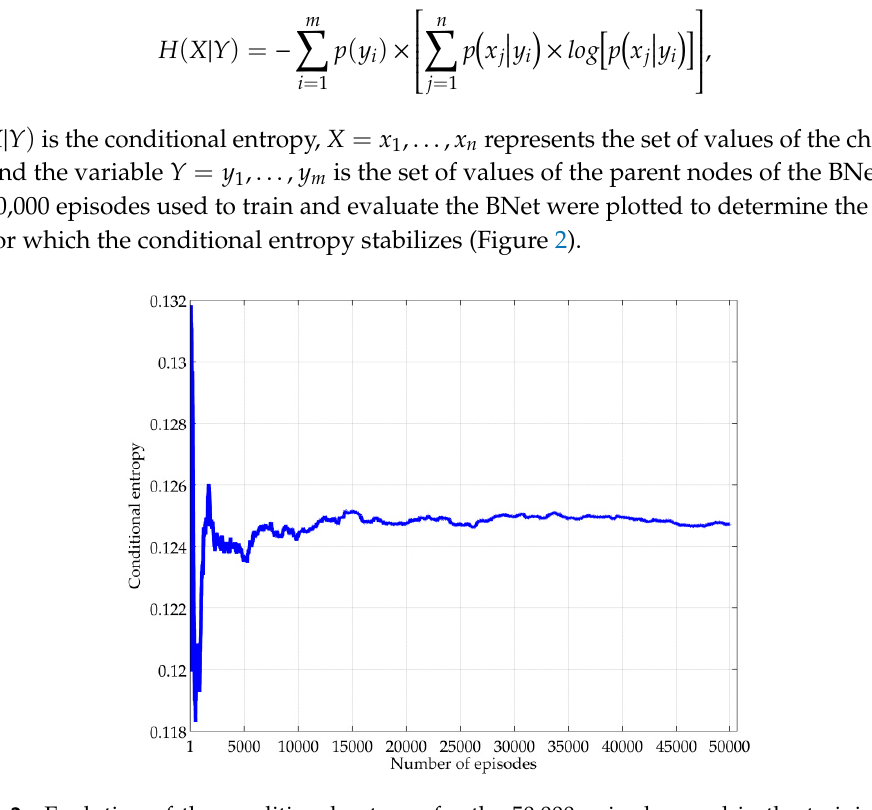
Figure 2. Evolution of the conditional entropy for the 50,000 episodes used in the training and evaluation of the BNet.